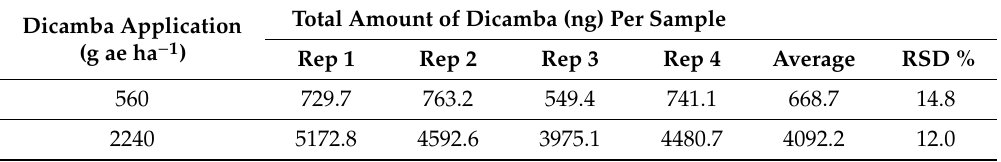
Table 3. Dicamba levels in air